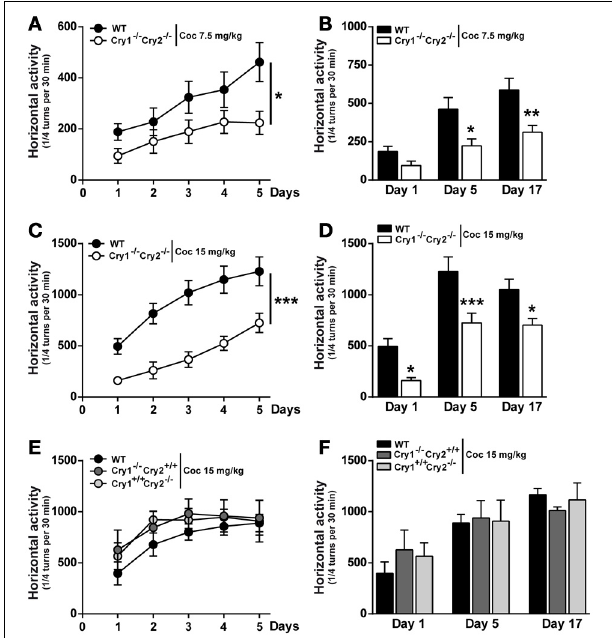
FIGURE 3 | Cocaine-induced acute hyperlocomotion and locomotor sensitization in Cry1 − / − Cry2 − / − mice. (A and C) Locomotor activity induced by repeated cocaine administration (7.5 and 15mg/kg) in wild type (WT) and Cry1 − / − Cry2 − / − mice ( n = 10–12 per experimental group). Data (means ± sem) were analyzed using Two-Way ANOVA repeated measures: A [Time × Genotype: F ( 4 , 76 ) = 2 . 783, P = 0 . 0325; Time: F ( 4 , 76 ) = 17 . 95, P < 0 . 0001; Genotype: F ( 1 , 19 ) = 3 . 883, P = 0 . 0635], C [Time × Genotype: F ( 4 , 76 ) = 3 . 302, P = 0 . 015; Time: F ( 4 , 76 ) = 53 . 45, P < 0 . 0001; Genotype: F